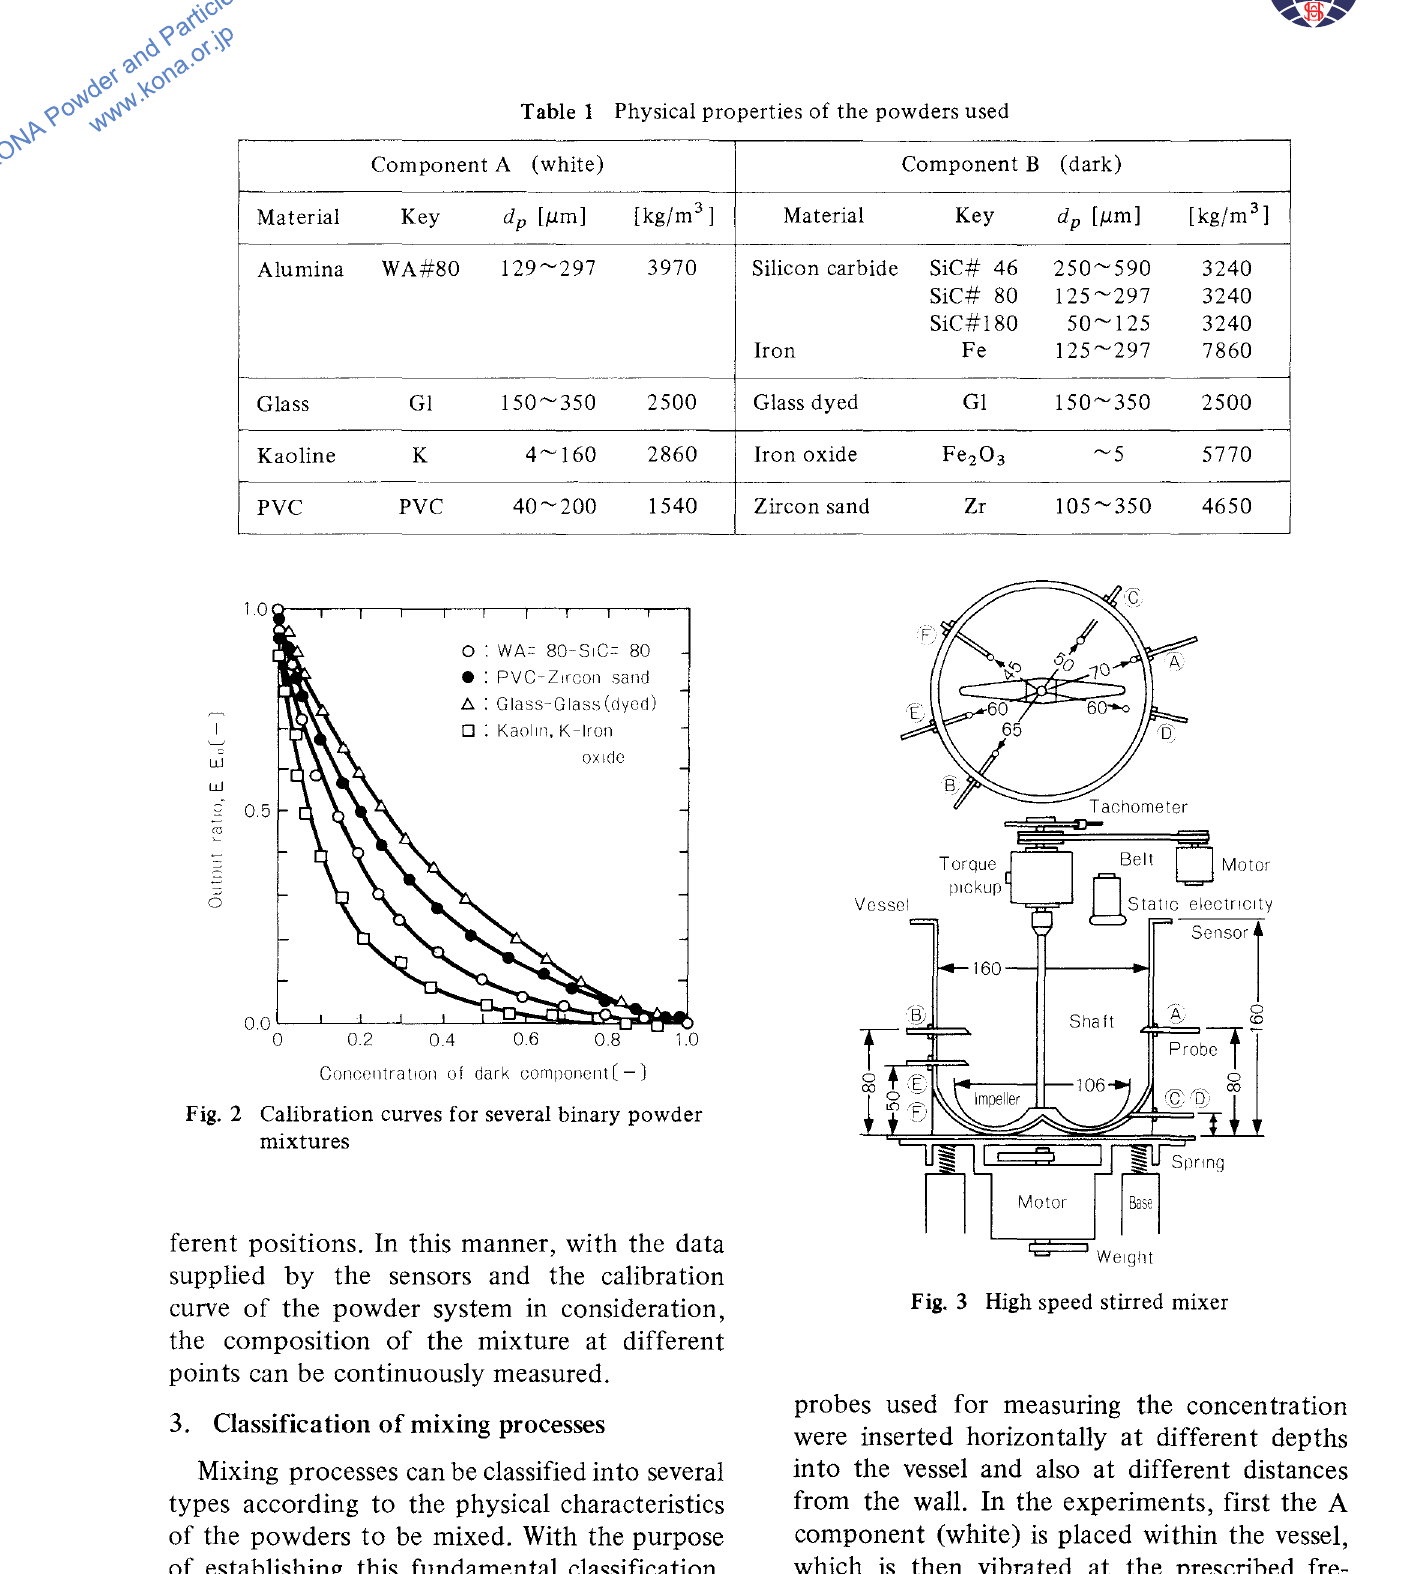
Table 1 Physical properties of the powders used